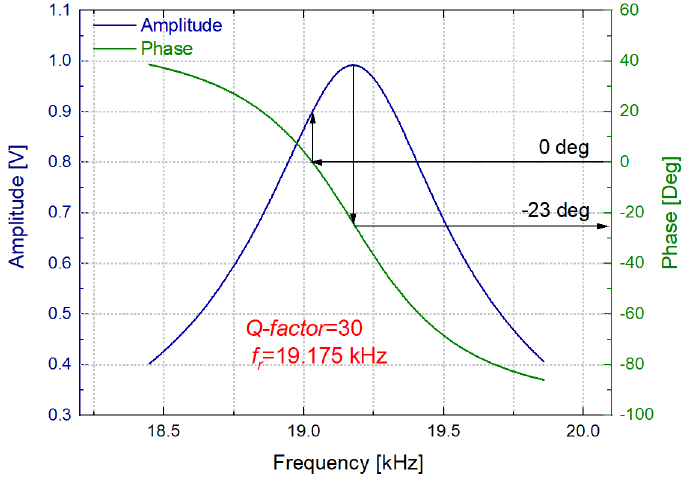
Figure 12. Open loop response of the interface circuit for the 32 − mode in the grape must model solution N 1 . solution N 1